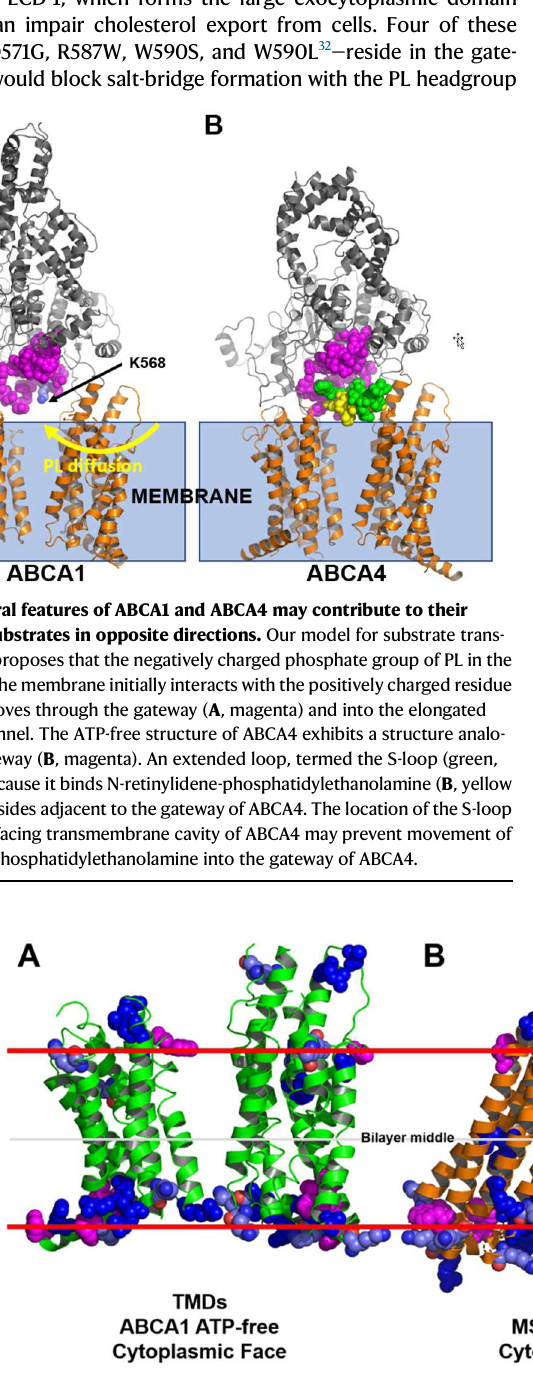
andarginineresiduesarecyan. A ATP-freehumanABCA1(PDBentry5XJY) 13 . B ATP- free S. Typhimurium MsbA (PDB entry 6BL6) 62 . C Six aligned structures of MsbA orthologs from three different bacterial species (PDB entries 2HYD, 3B5Z, 3B60, 5TTP, 5TV4, and 6BPP) 63 – 66 .